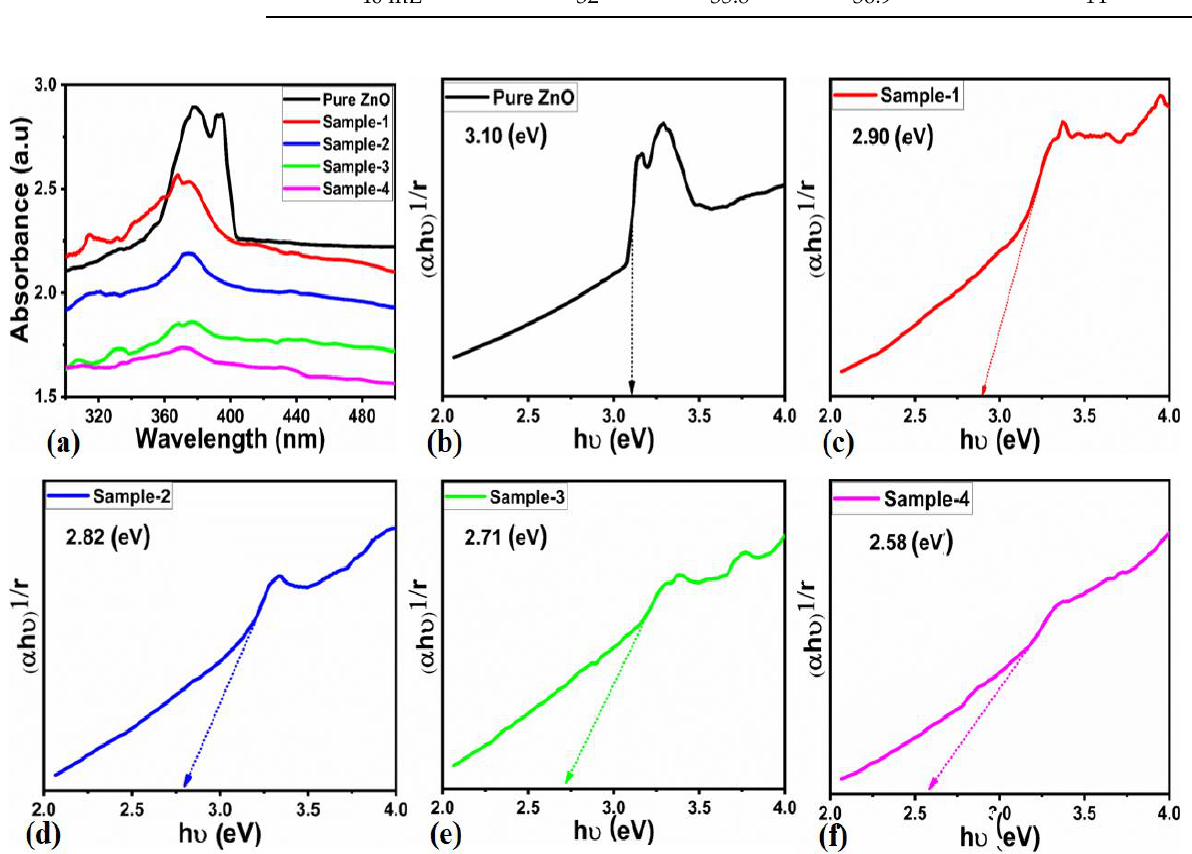
Figure 3. ( a ) UV-visible absorbance spectra of pure ZnO and sample-1, sample-2, sample-3, and sample-4, ( b – f ) Corresponding Kubelka–Munk plots.